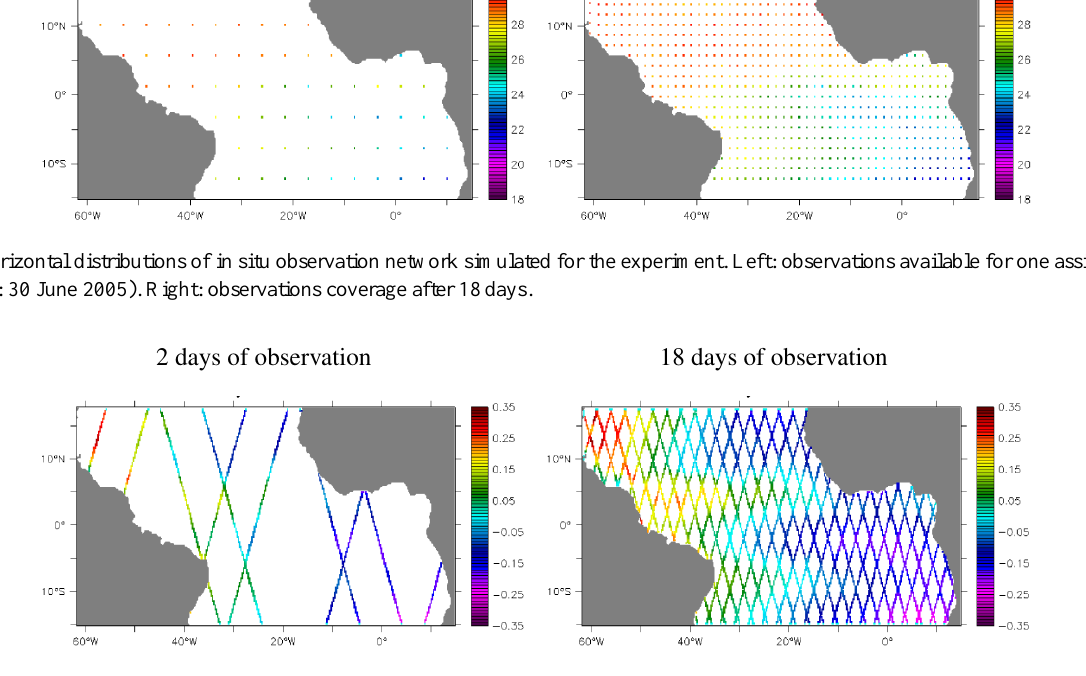
Fig. 3. Horizontal distribution of altimetric observations network simulated for the experiment. Left: observations available for one assimilation step (here: 30 June 2005). Right: observations coverage after 10 days.